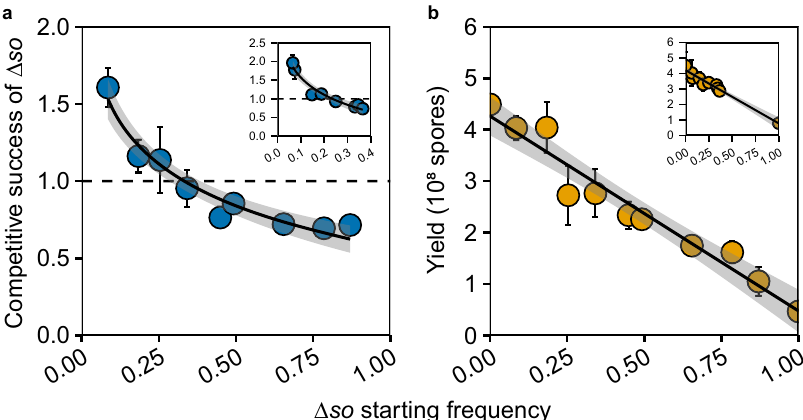
Fig. 1 Negative frequency dependence of the bene fi t of Δ so in competition with wild type and the negative effect of Δ so on sporulation. a In pair-wise competitions with the wild type, Δ so has a competitive advantage relative to wild type at frequencies below ~30%. The competitive success of Δ so was calculated using phenotype counts after 4 days as the frequency of Δ so after the competition divided by the initial frequency of Δ so . b As the frequency of Δ so spores in the competition mixture increases total spore production decreases. The inserts in a and b show the results of a separate experiment testing a narrower range of frequencies around 25%. In both panels, shaded areas around the trendlines are 95% con fi dence areas of the fi tted curve. In both panels, error bars are 95% con fi dence intervals around means calculated from three biological replicates. Source data are provided as a Source Data fi